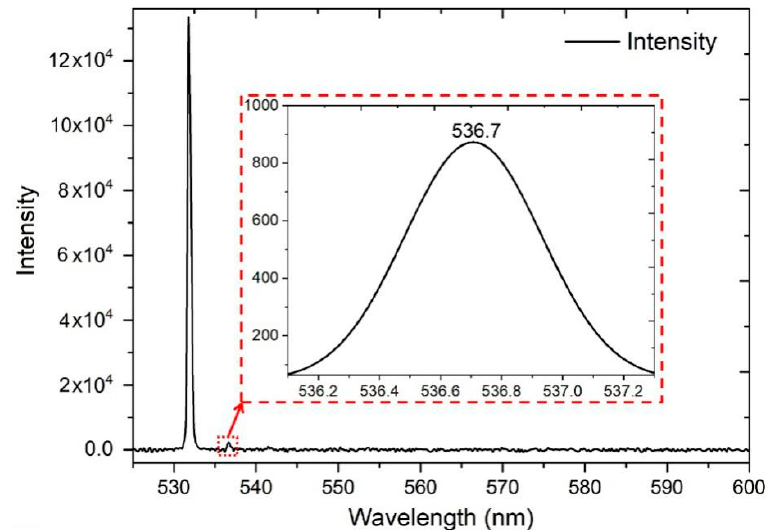
Figure 9. The spectrum of laser radiation transmitted through the BWG impregnated with rhodamine and containing ethanol molecules in the cladding. The input power is 10 mW. The inserted image is the enlarged spectrum of the peak at 536.7 nm with an FWHM (full width at half maximum) bandwidth of ~0.5 nm.